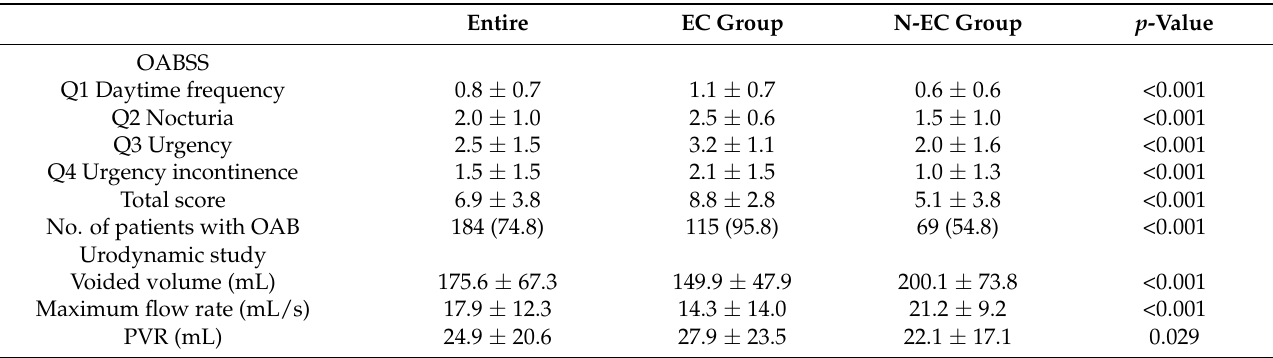
Table 3. Differences in urological parameters.